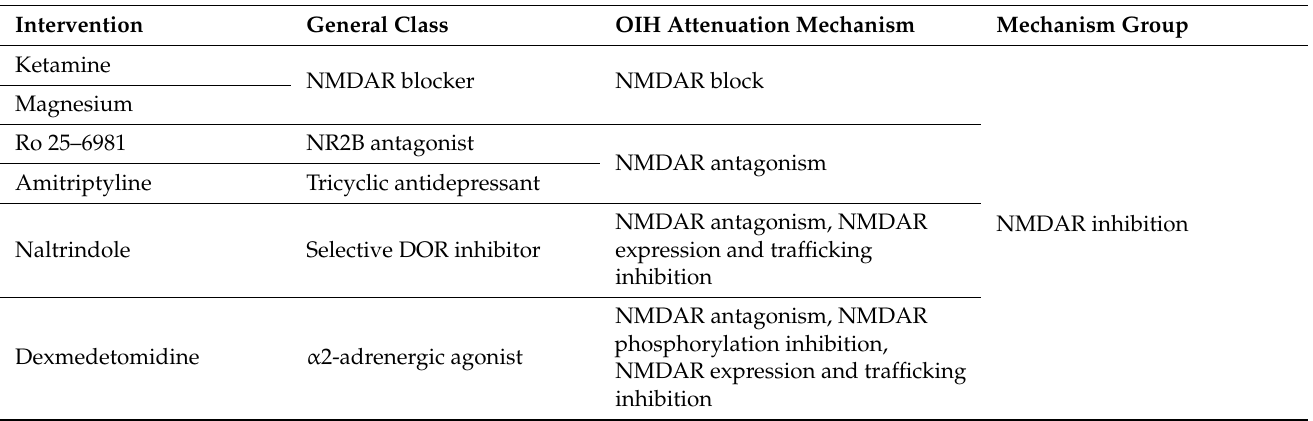
Table 6. Mechanisms of the interventions in remifentanil trials. General class of 24 interventions, OIH attenuation mechanism, and mechanism group based on the shared pathway for OIH attenuation. Intervention General